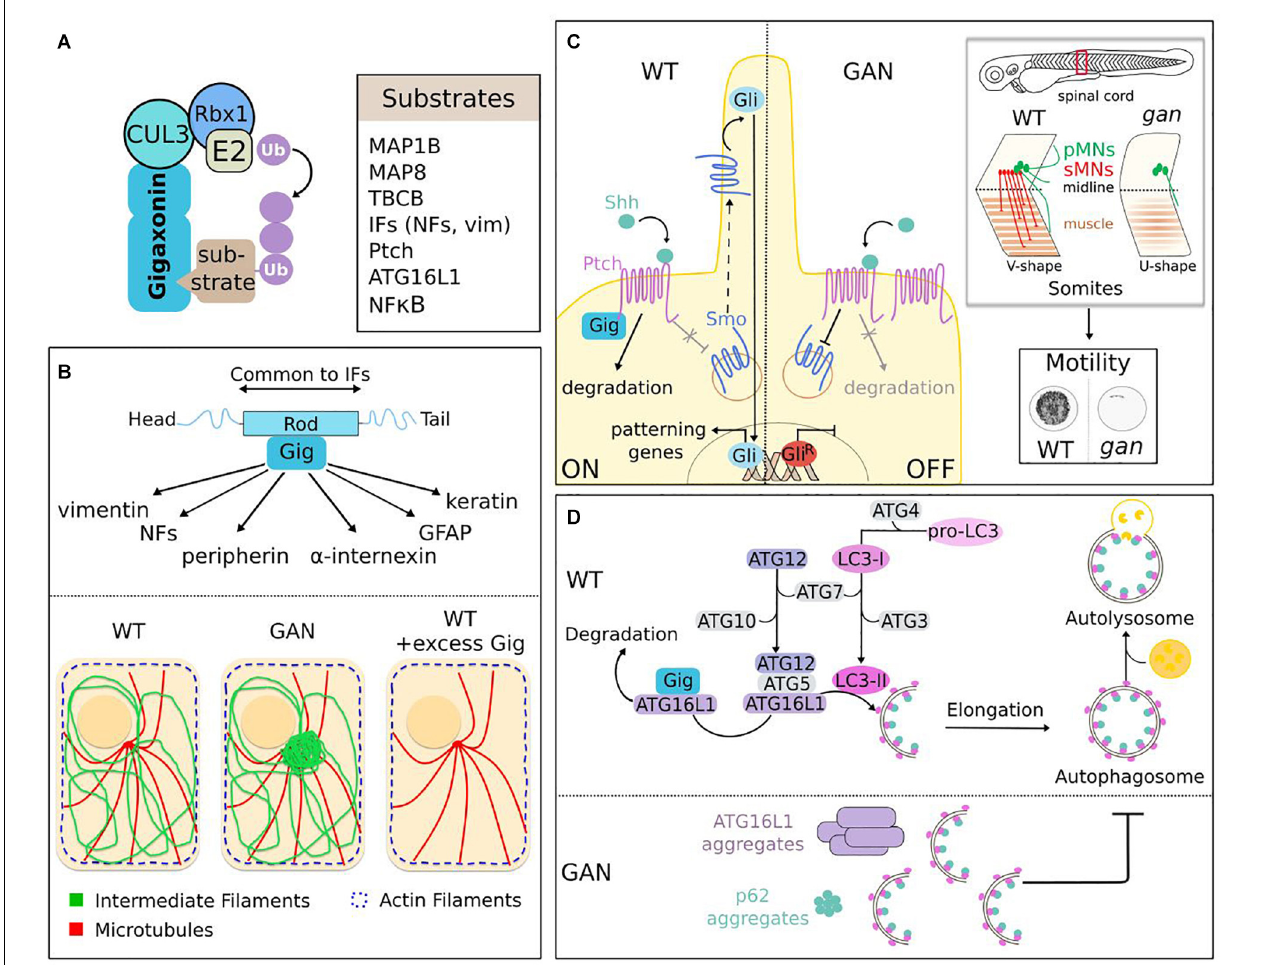
FIGURE 7 | Functions of the Gigaxonin-E3 ligase. (A) Identified substrates for Gigaxonin include cytoskeletal components (MAPs, TBCB, IFs), Shh receptor (Ptch), autophagy core protein (ATG16L1) and transcriptional factor (NF K B). (B) Gigaxonin controls the turn-over of the IF family. Through interaction with the central α -helical rod domain, a common domain of IF proteins, Gigaxonin controls the steady-level of IF family, including neuronal (NFs, peripherin, and α -internexin) and non-neuronal (vimentin, GFAP, and keratin) IF types. This is mediated by Gigaxonin-dependent ubiquitination (as revealed for peripherin). In absence of Gigaxonin (patients and GAN models), IF proteins bundle at perinuclear region, while actin and microtubules do not show overt alteration. Excess of Gigaxonin completely destroys IFs, including bundles in GAN samples. (C) Control of the initiation of Shh signaling by Gigaxonin is essential for locomotion. In normal condition (left), Gigaxonin initiates signal transduction by degrading Shh-bound Ptch receptor, hence suppressing its constitutive inhibition on the signal transducer Smo, allowing its translocation to the primary cilium, and leading to the transcriptional activation of Gli. In absence of Gigaxonin (right), the repression of Smo is maintained by accumulated Ptch receptor, which hampers the initiation of Shh signaling and favors the generation of a repressor form of Gli. In zebrafish, this defective Shh signaling impairs motility of gan larvae (cumulative representation of the spontaneous locomotion of larvae for 1 h). This severe motility defect is caused by a dramatic remodeling of spinal cord architecture, [shortening of pMNs axons (primary motor neurons, green), defective production of sMNs (secondary motor neurons, red)], and failure to generate proper neuromuscular junctions (NMJ). This phenotype is accompanied by a muscular defect (neuronal-independent or dependent), characterized by “U-shape” myofibers instead of the normal “V-shape.” (D) Gigaxonin regulates autophagosome production. Elongation of phagophore membrane involves two ubiquitin-like conjugation systems: ATG12 and LC3 undergo transfer from E1 (ATG7) to E2 (ATG10 and ATG3) enzymes. ATG12-ATG5 subsequently forms a complex with ATG16L1, which addresses it to the nascent membrane to act as an E3 ligase for the lipidation of LC3, to generate LC3-II. Gigaxonin induces the ubiquitin-dependent degradation of ATG16L1, and its absence in GAN neurons causes a failure to generate productive autophagosomes upon autophagy induction. As a result, ATG16L1 bundles in GAN neurons, the autophagy receptor P62 accumulates and autophagosome-lysosome fusion is impaired, hence blocking autophagy